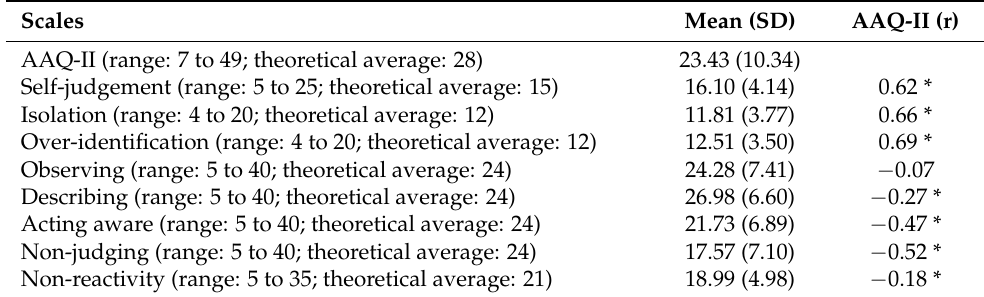
Table 3. Descriptive and correlations between the AAQ-II and